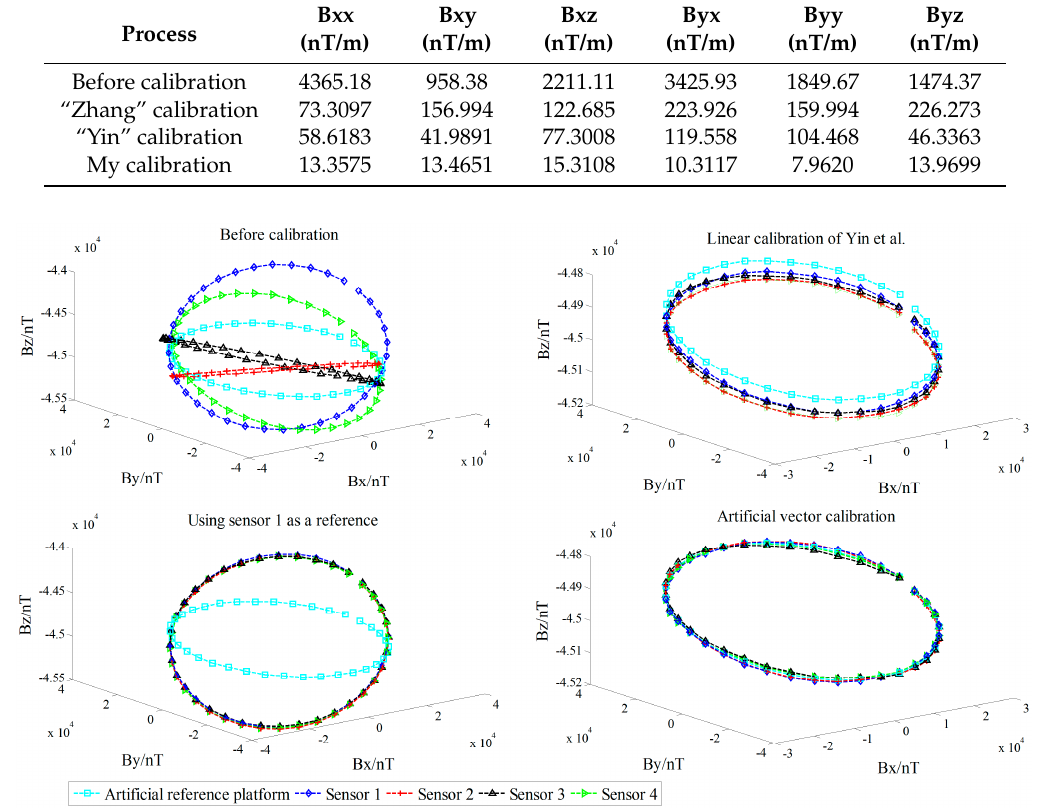
Figure 11. Spatial distributions of tricomponents before and after calibration of the first 36 orientations.